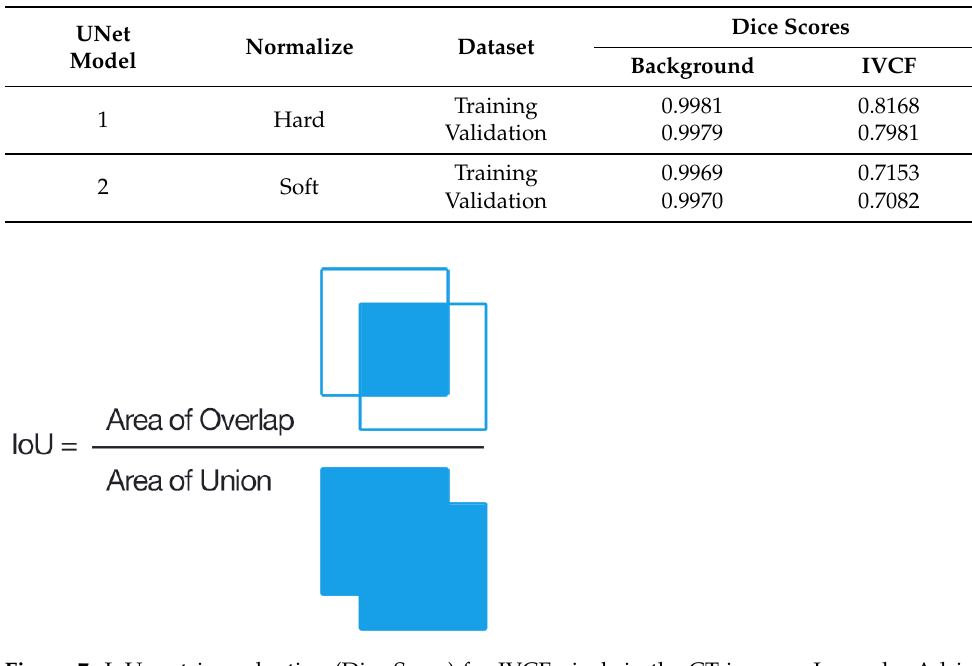
Figure 7. IoU metric evaluation (Dice Score) for IVCF pixels in the CT images. Image by Adrian Rosebrock, distributed under a CC BY-SA 4.0